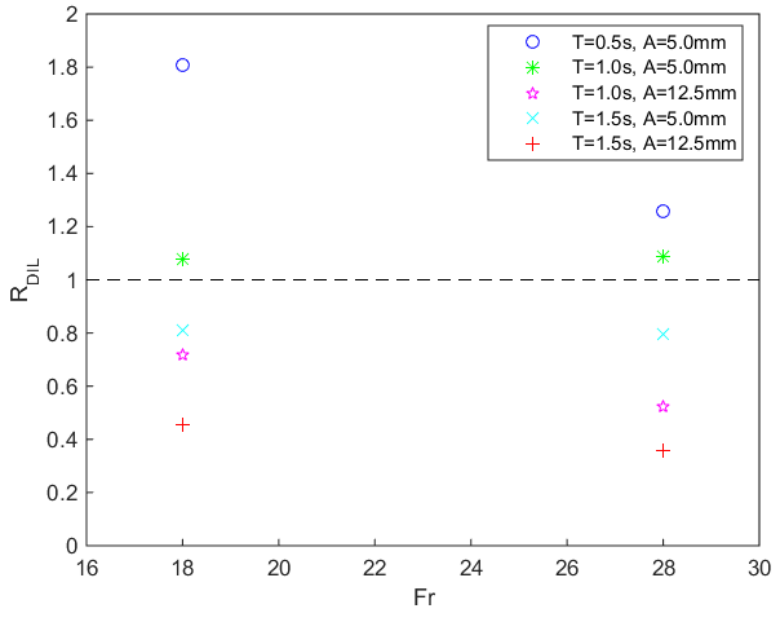
Figure 12. R DIL versus Fr ; R DIL is the ratio of the dilution of NBJs under waves to the dilution of jets in stagnant environment; (wave parameters in the legend).